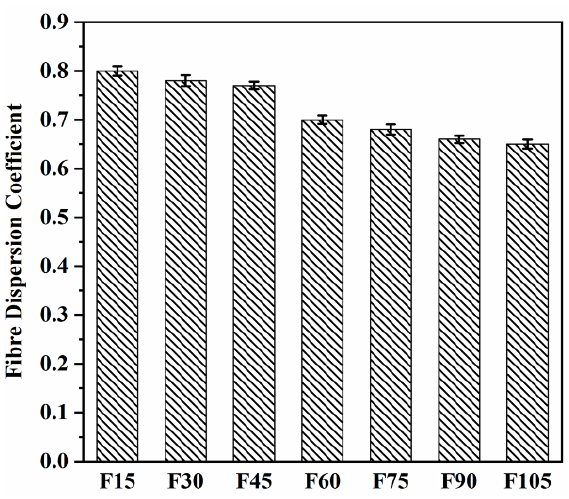
Figure 12. Fibre coefficients of F15–F105.